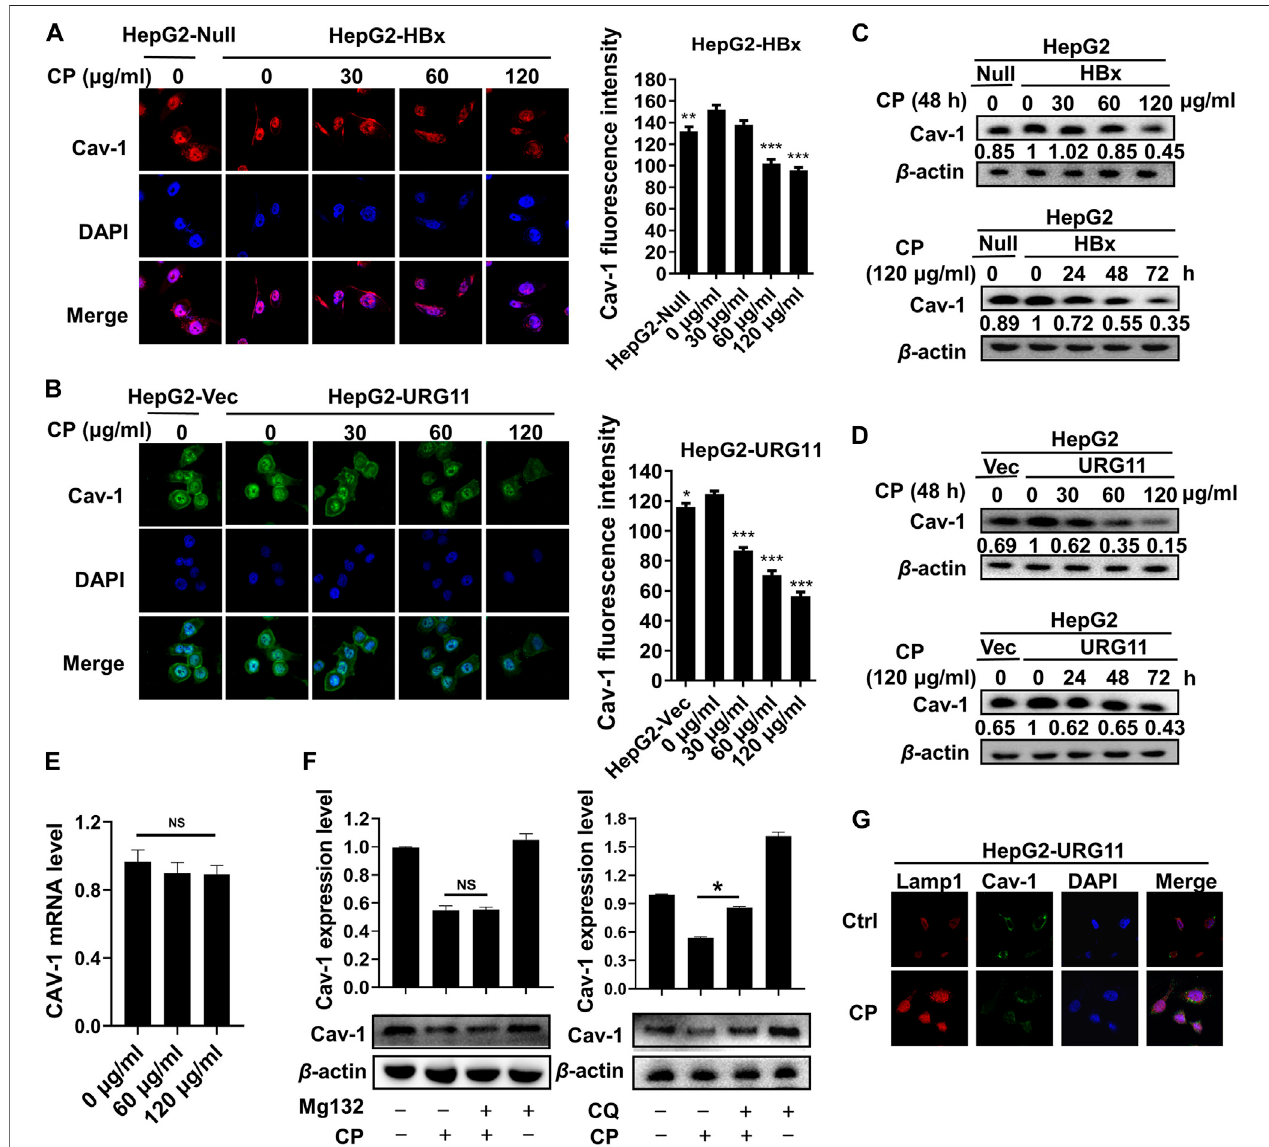
FIGURE6| CPpromotedautophagicdegradationofCav-1. (A,B) Immuno fl uorescencestainingrevealedthattheimmunosignalofCav-1wasinhibitedbyCPina concentration-dependent manner in HepG2-HBx and HepG2-URG11 cells. (C, D) Westernblot analysis showed thatCP treatment decreased the expression ofCav-1 inadose-andtime-dependentmannerinHepG2-HBxandHepG2-URG11cells. (E) CPhavenosigni fi canteffectonmodulatingthemRNAexpressionofCav-1. (F) The autophagic degradation inhibitor CQ, rather than MG132, blocked the degradation process of Cav-1 by CP. (G) Immuno fl uorescence array showed that co- localization ef fi ciency of Lamp1 and Cav-1 was increased in CP treatment group. All values represented the means ± SD ( n (cid:1) 3, * p < 0.05, ** p < 0.01, *** p < 0.001, NS: p > 0.05 not signi fi cant).